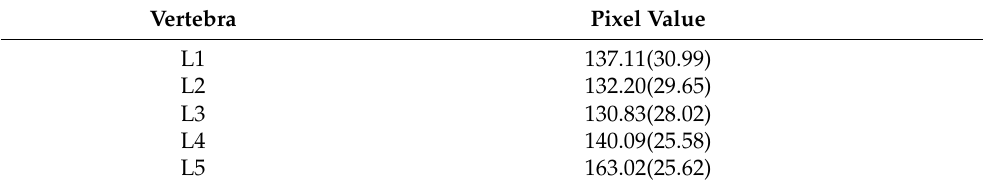
Figure 4. Example of random spine cutout. ( b , c ) are results of the random spine cutout performed on ( a ). Table 1. Average pixel values inside each vertebra (and the standard